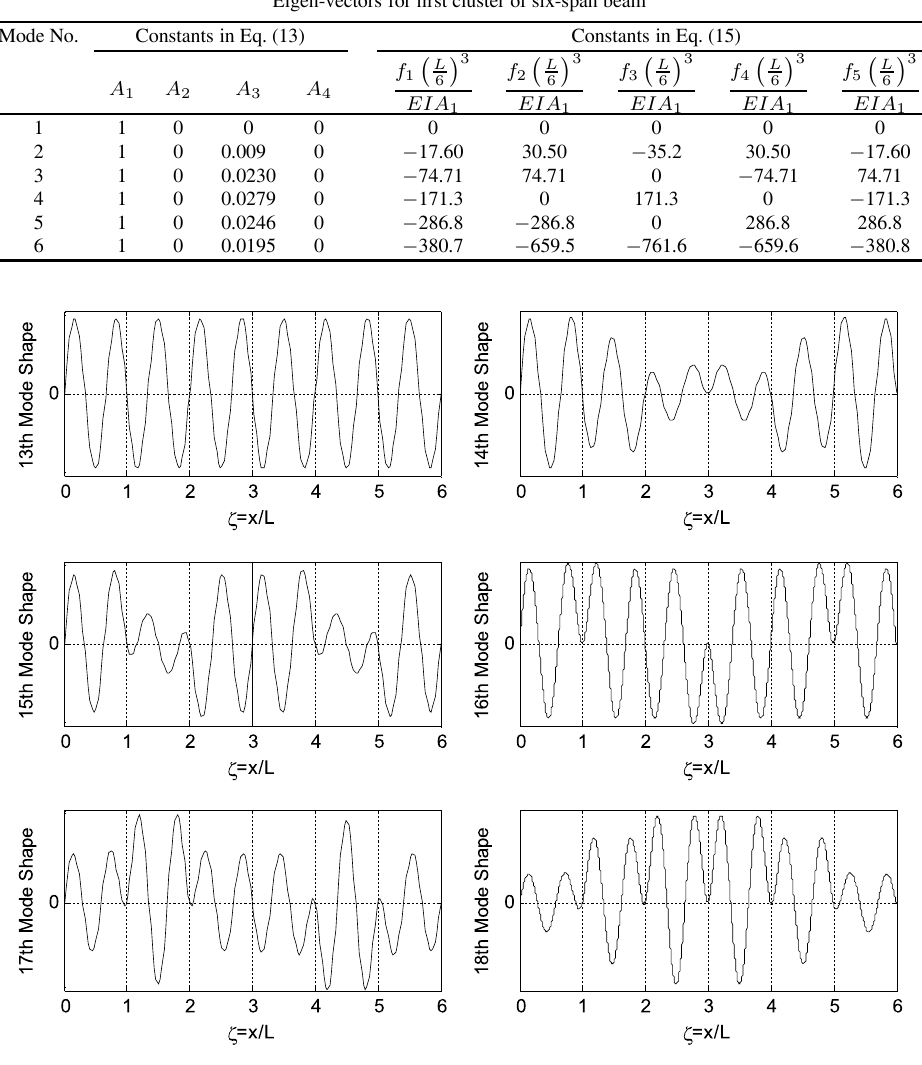
Fig. 6. Third cluster of mode shapes of the six-span